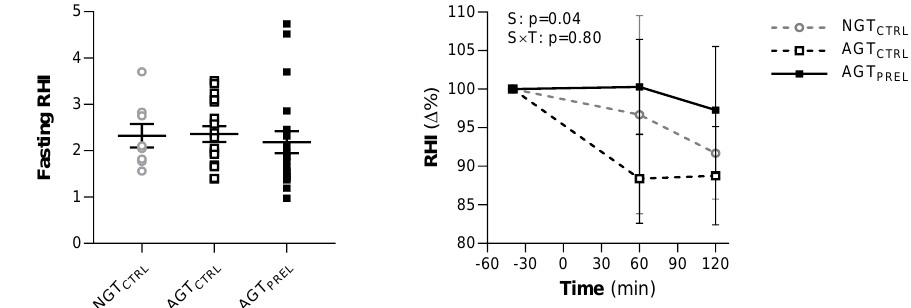
Figure 2. Fasting endothelial function assessed by the reactive hyperemia index (RHI) and its percentage changes (Δ%) during two 75 g oral glucose tolerance tests preceded by water (CTRL) or a protein/lipid preload (PREL) in subjects with normal glucose tolerance (NGT) or abnormal glucose tolerance (AGT). Data are mean ± SEM. Baseline differences between the three groups were tested by Kruskal – Wallis test followed by post-hoc pairwise comparisons. In AGT, repeated measures were analyzed by mixed models including study (S), time (T), and an interaction term (S × T) as fixed effects and subject as random effect. p value for time effect is <0.05.